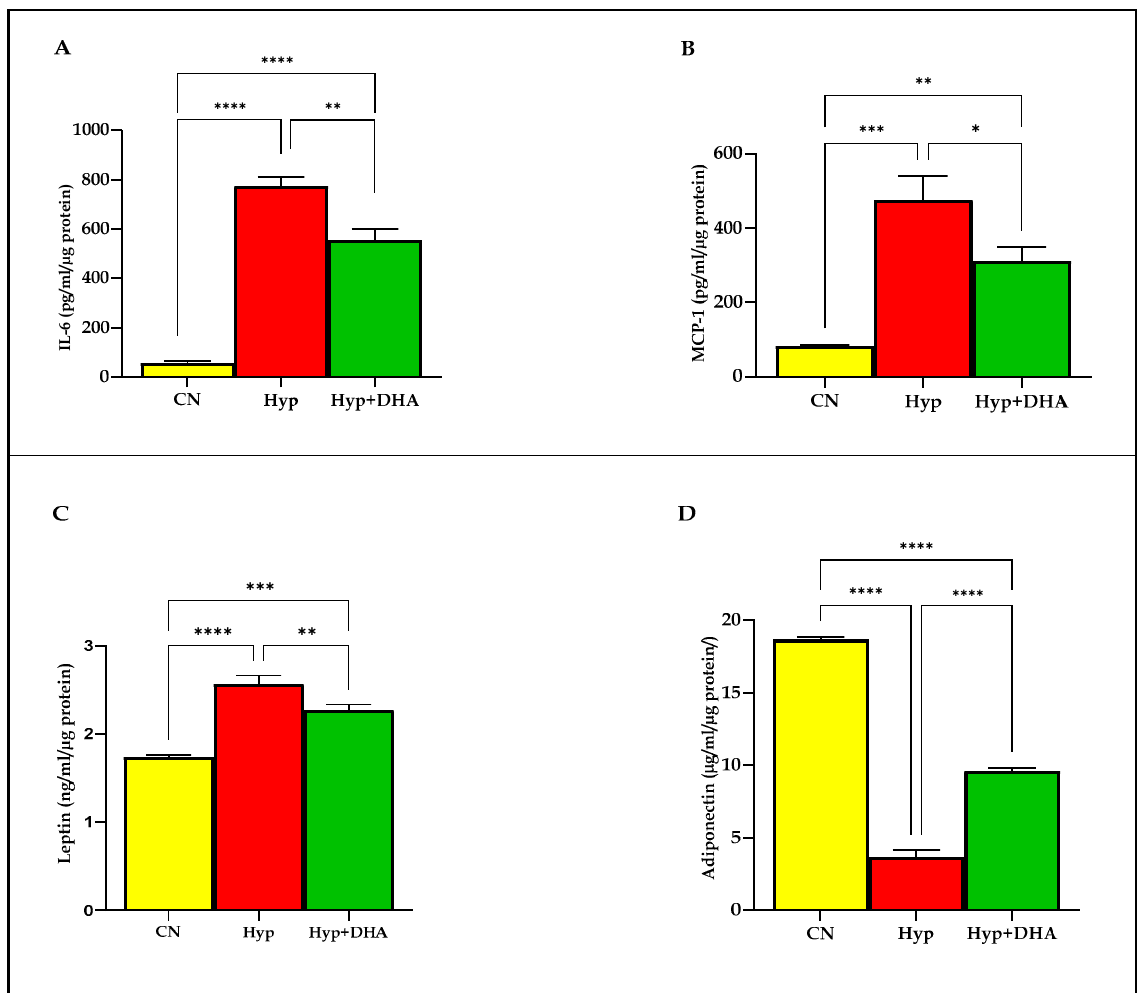
Figure 5. Quantification of adipocytokine release in CM using Eliza: impact of DHA treatment of hypoxic 3T3L-1 adipocytes. 3T3-L1 adipocytes (7–10 days post-differentiation) were subjected to